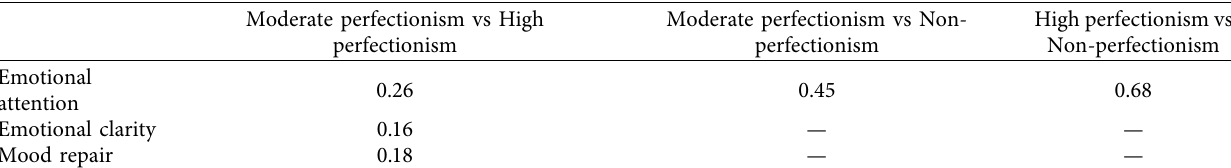
Table 4: Cohen’s d indexes for post-hoc contrasts between the mean scores obtained by the three classes on EI